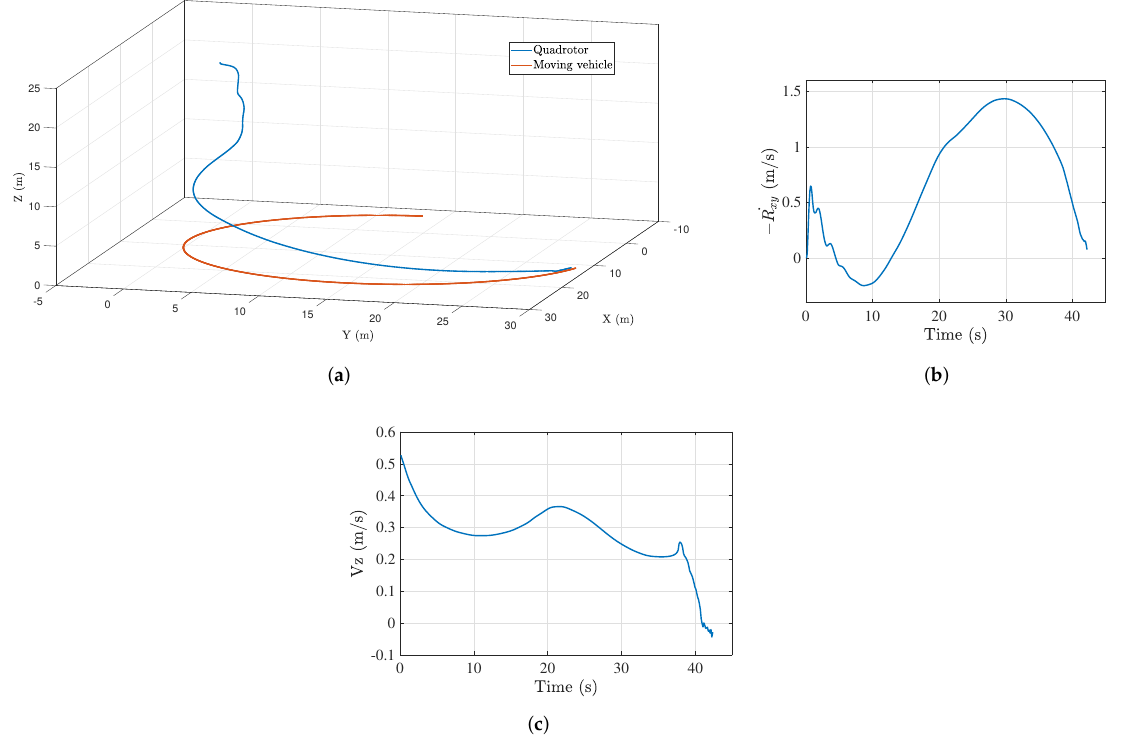
Figure 7. ( a ) Landing trajectory followed by UAV when ground vehicle moves along a circular path (15 m radius); ( b ) closing velocity profile ( xy plane) of the UAV when ground vehicle moves along a circular path (15 m radius); ( c ) descend velocity of the UAV when ground vehicle moves along a circular path (15 m radius).